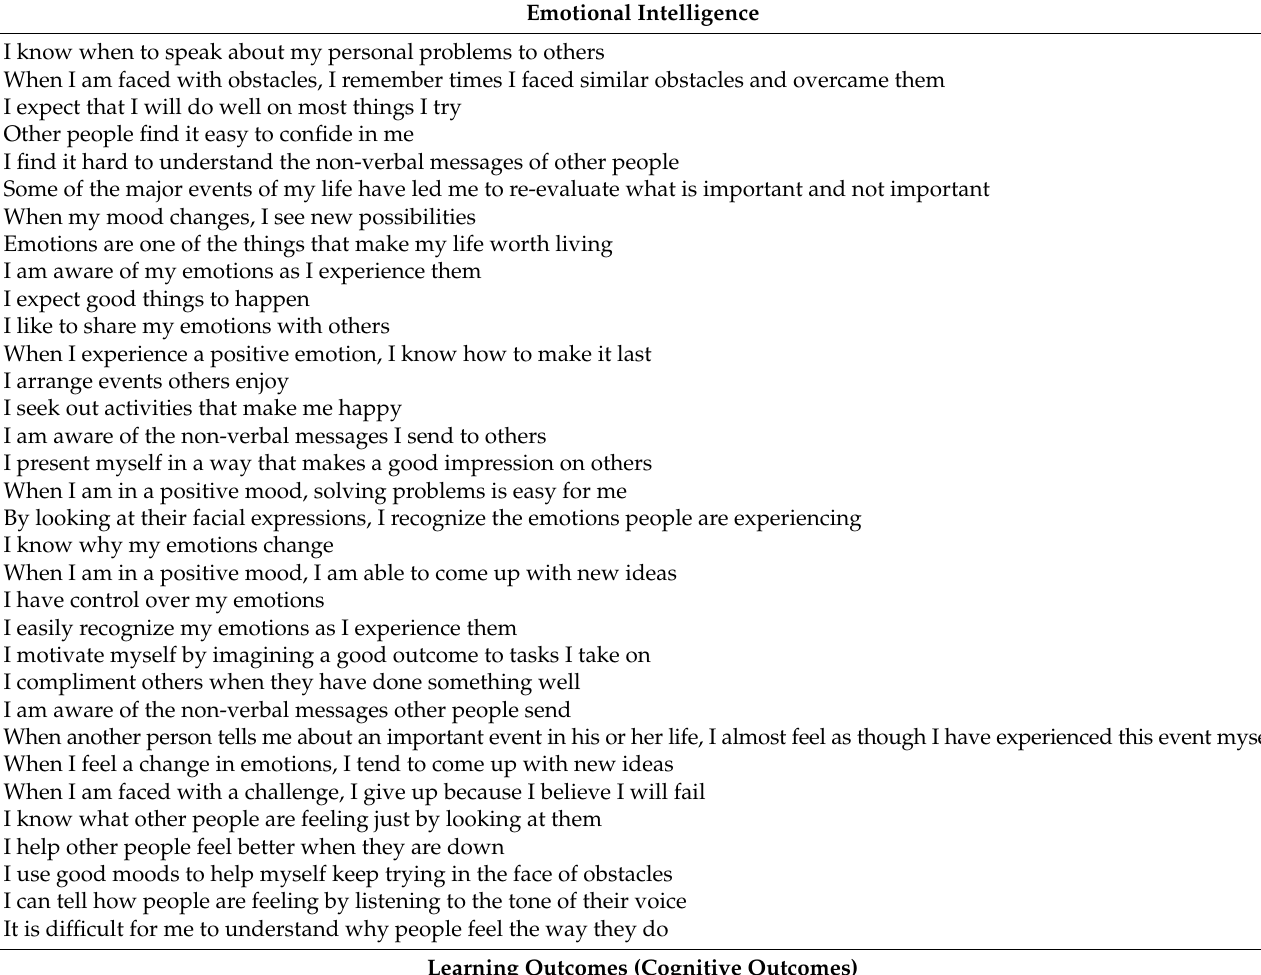
Table A2. Items used to operationalize